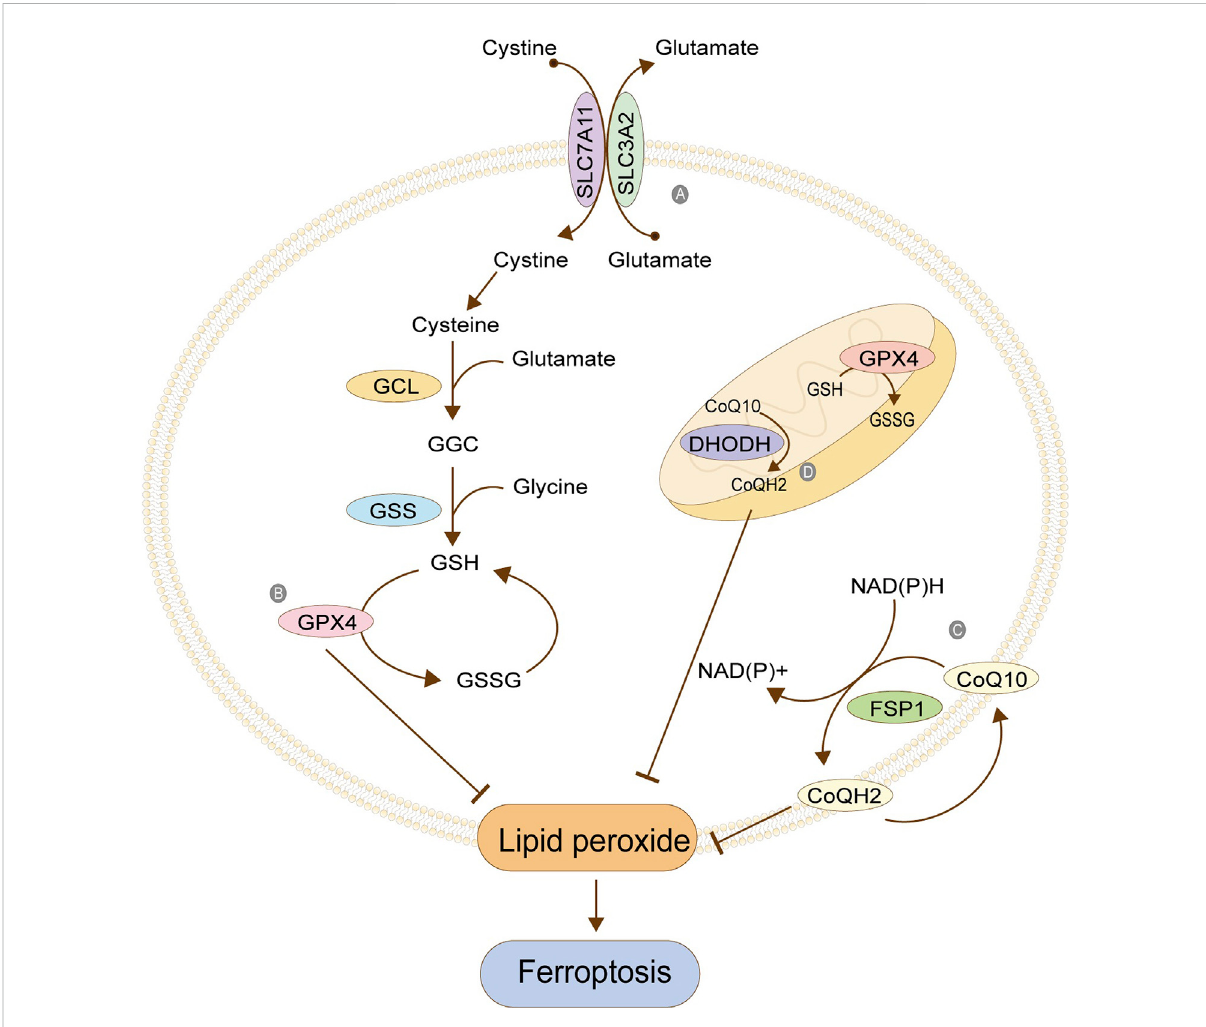
FIGURE 3 Antioxidant system. (A) Cystine/glutamate antitransporter; (B) Glutathione peroxidase 4; (C) FSP1/CoQ10; (D) Antioxidant system in mitochondria. The fi gure modi fi ed from (Anandhan et al.,